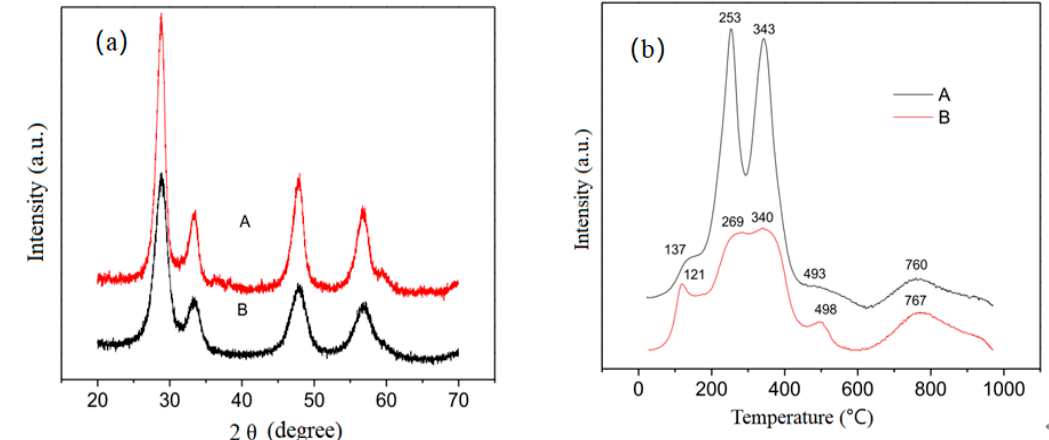
Figure 8. ( a ) XRD patterns of Mn 5 Ce 5 (CP) (A) and Mn 5 Ce 5 (ST) (B) catalysts and ( b ) H 2 -TPR profiles for Mn 5 Ce 5 (CP) (A) and Mn 5 Ce 5 (ST) (B) catalysts [59].